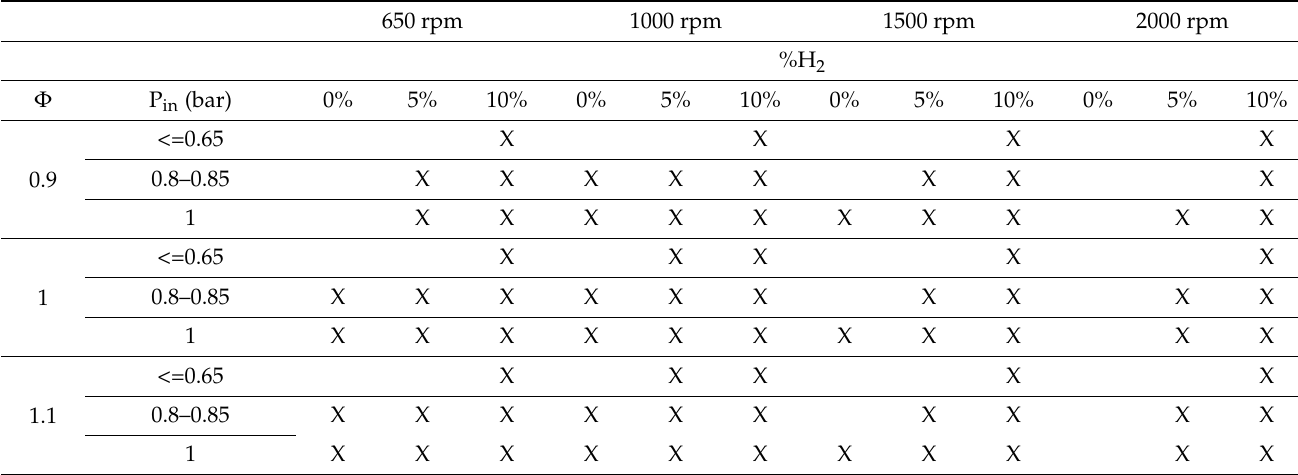
Table 4. Limits in operating the engine with ammonia for several engine speeds, equivalence ratios, percentages of H 2 as a function of intake